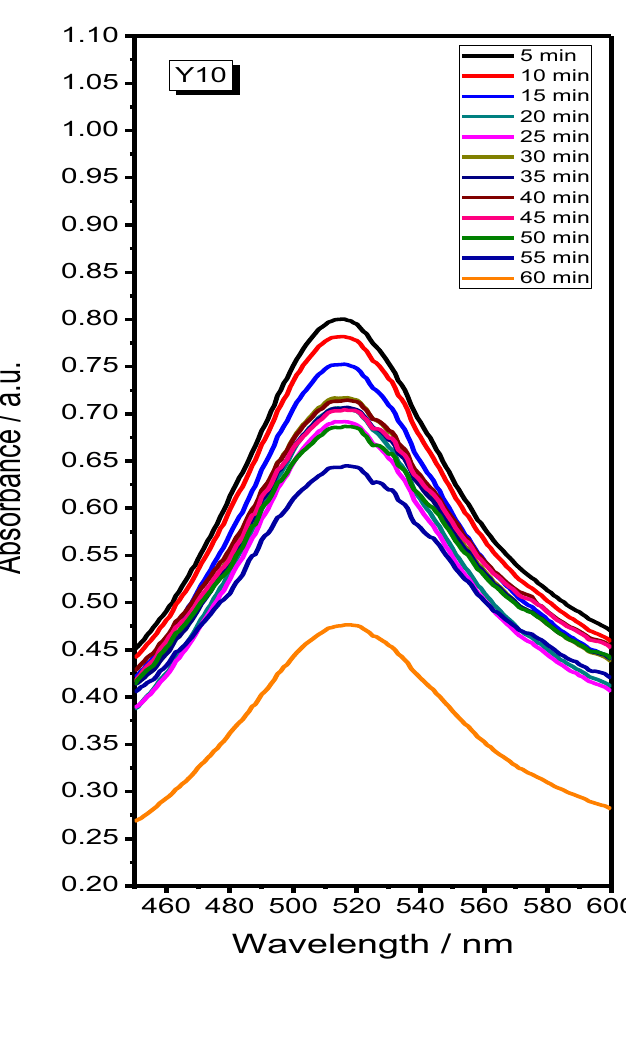
Figure 9. Time dependency of DPPH• scavenging in the presence of Y 2 O 3 nanocrystallites (Sample